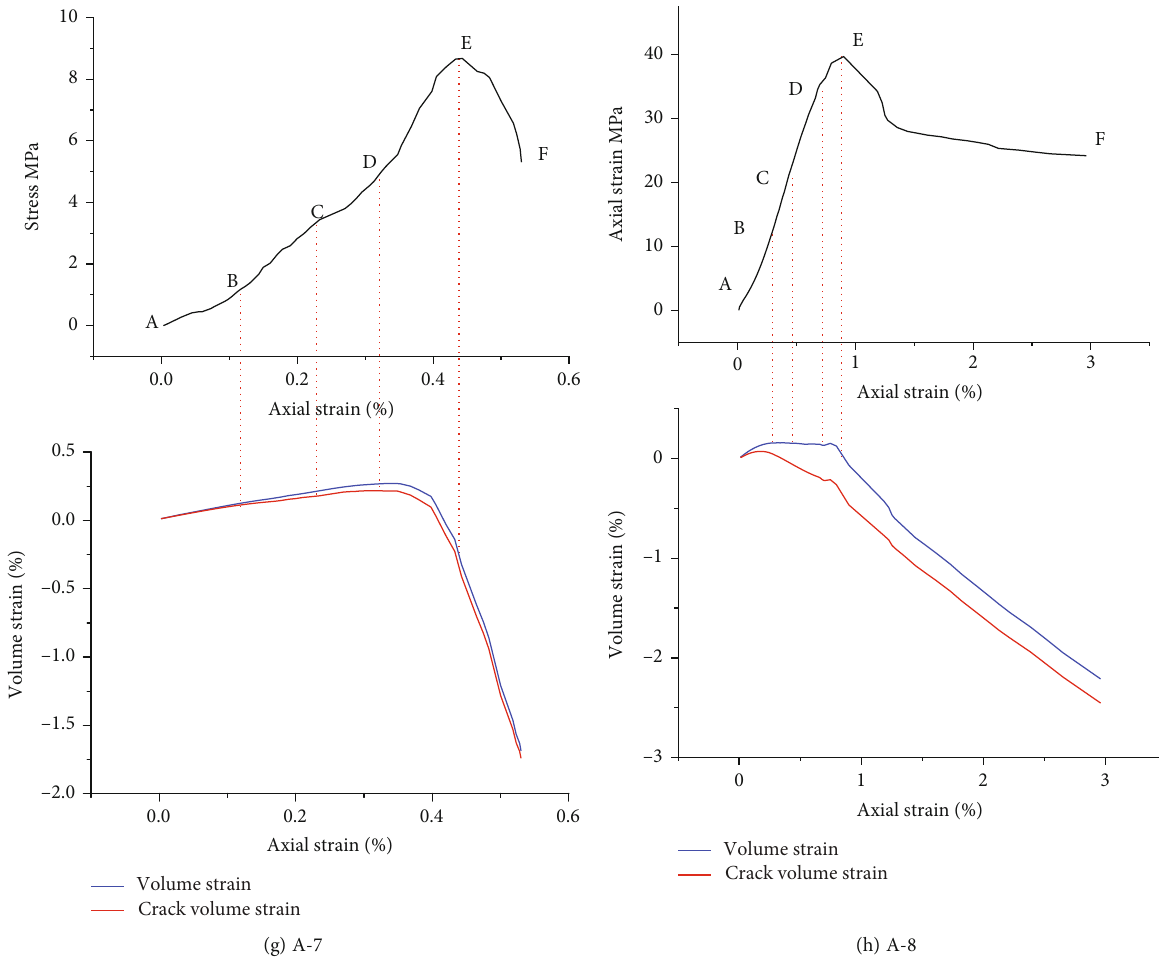
Figure 3: Stress-axial strain, volumetric strain-axial strain, and crack volume strain-axial